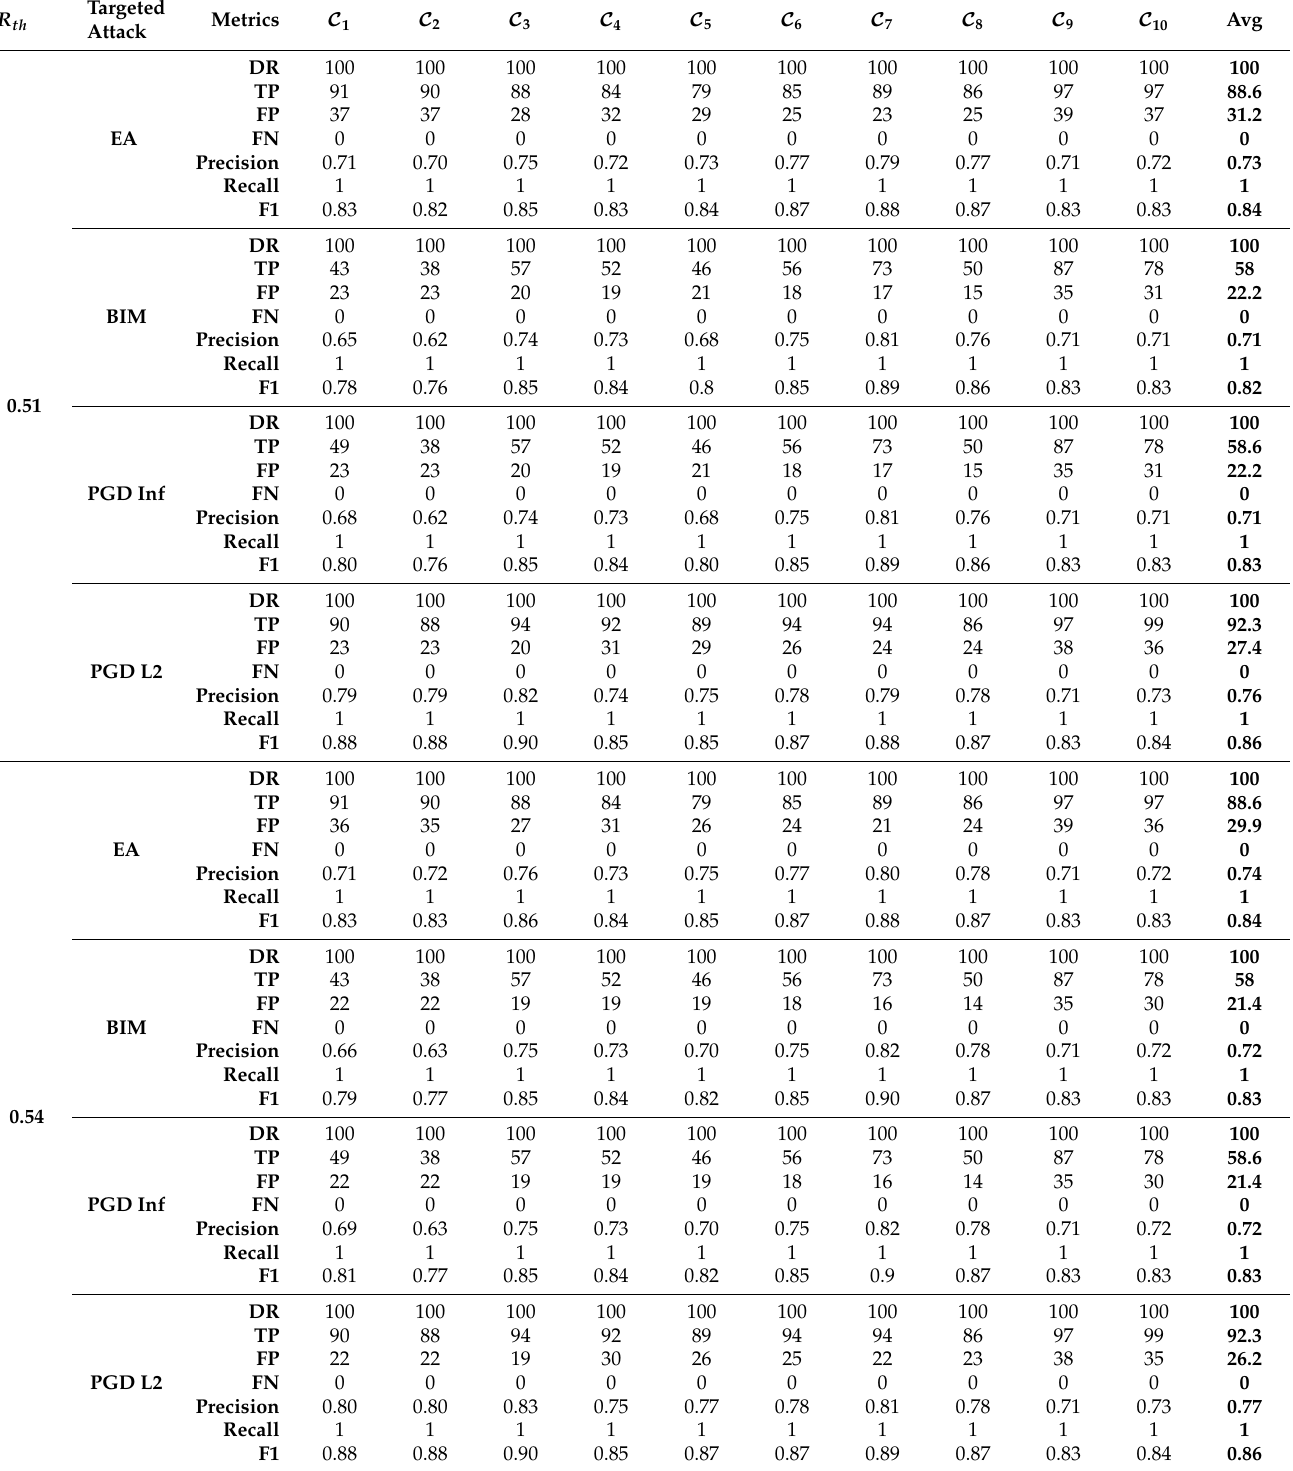
Table 9. Targeted attacks—DR as a percentage, and TP, FP, FN, precision, recall, F1 scores for CNN, per attack, for selected values of R th = 0.51 and 0.54, and their corresponding